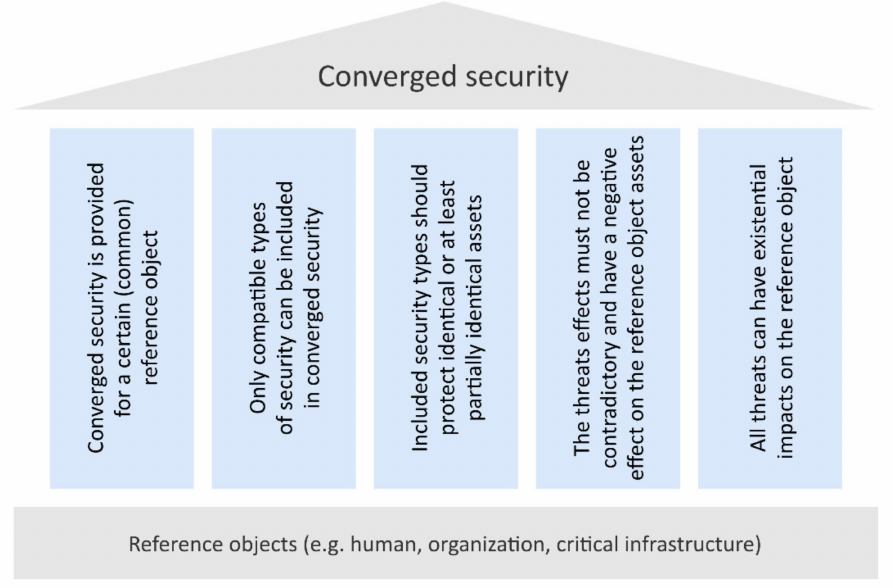
Figure 1. Basic Principles of Converged